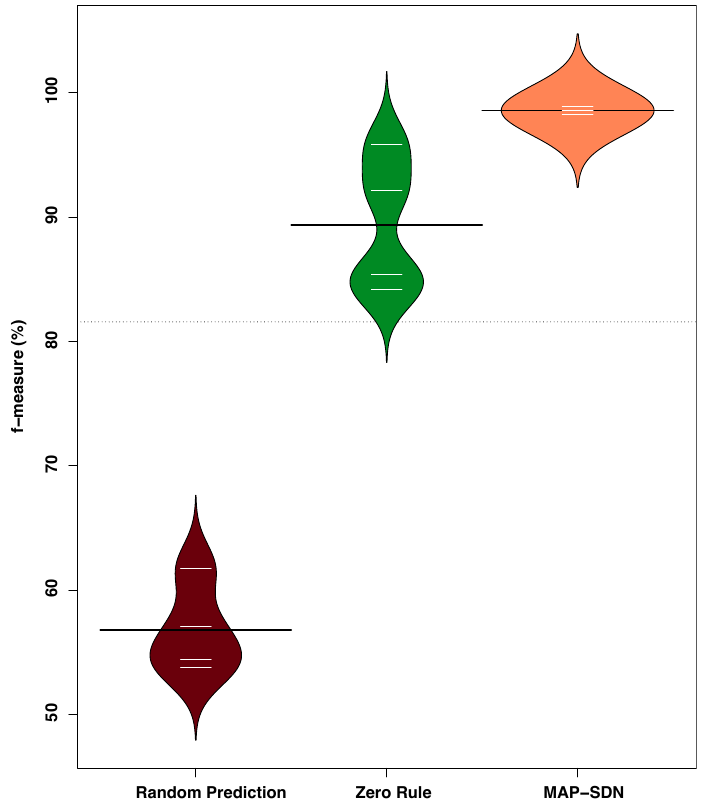
Figure 5. Accuracy distribution of MAP-SDN compared to RPA and